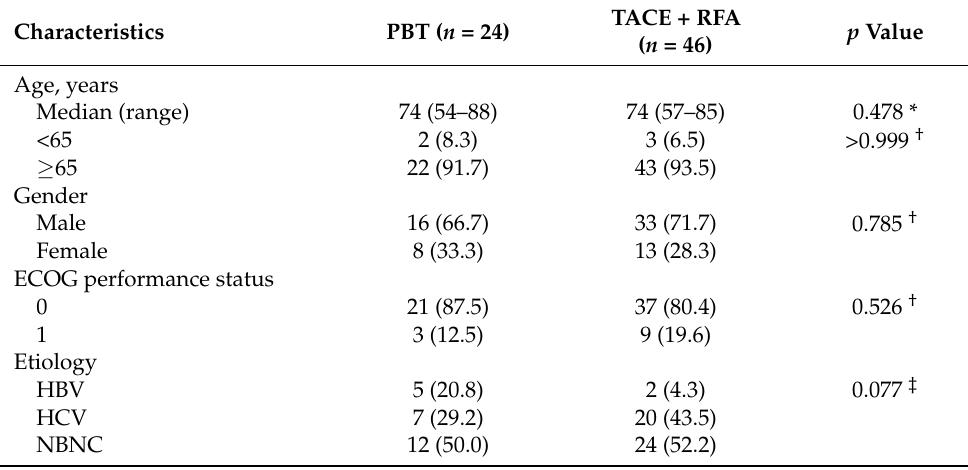
Table 1. Patients’ characteristics between proton beam therapy and TACE plus